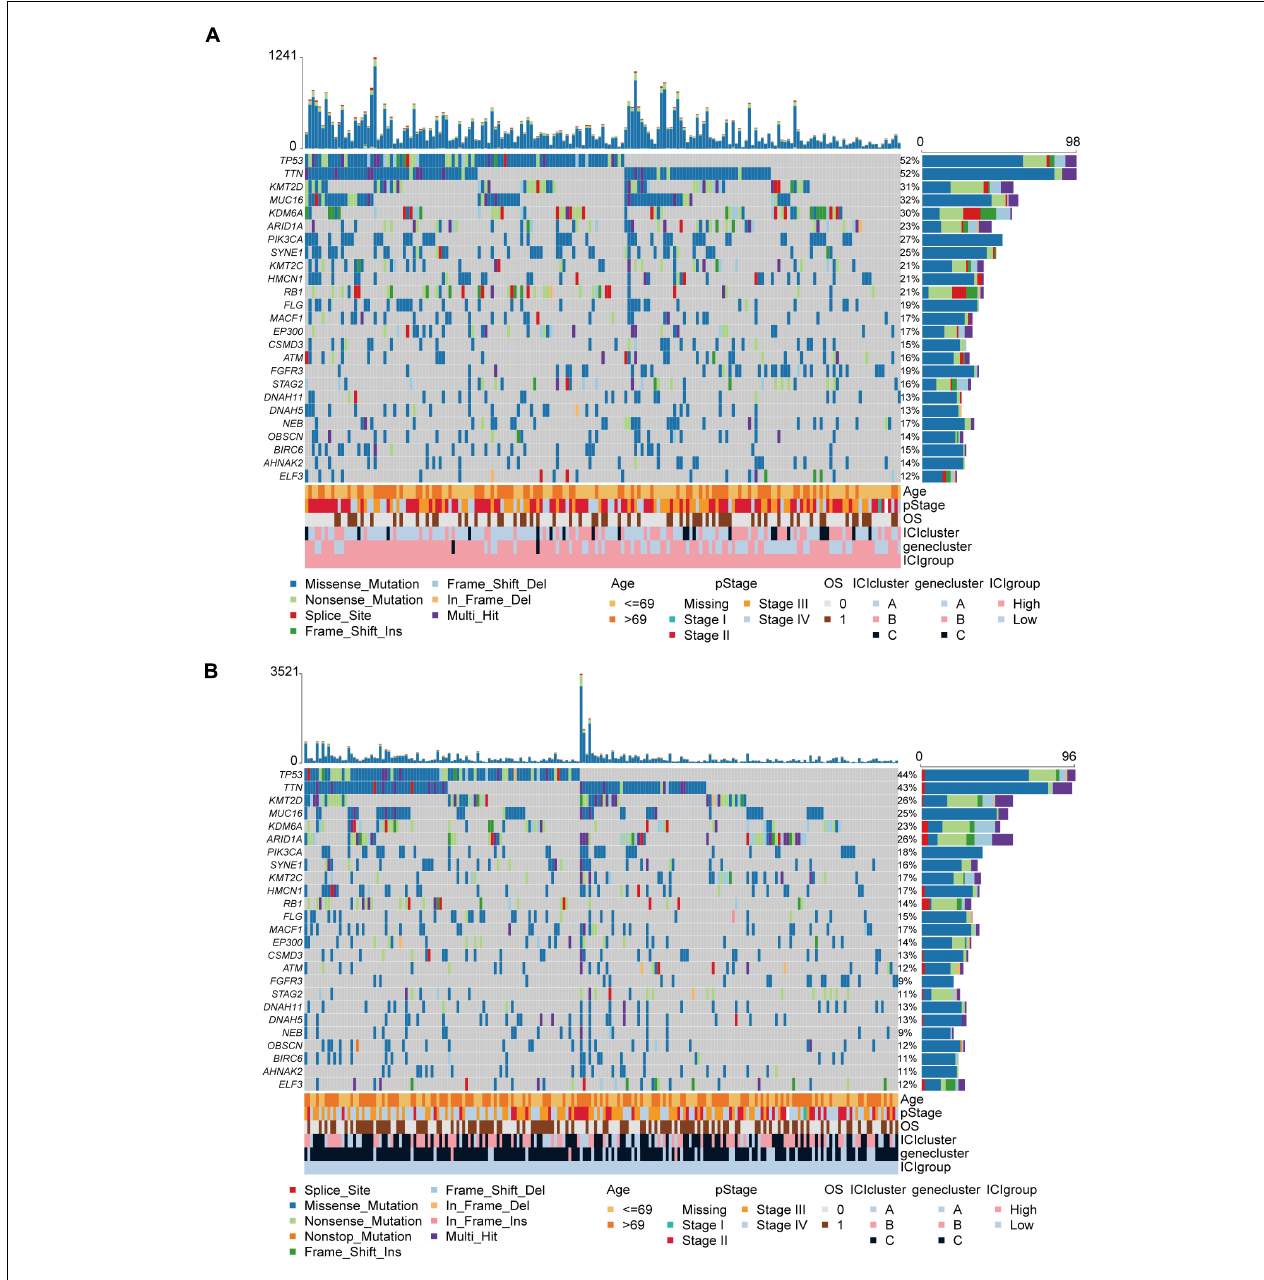
FIGURE 5 | The oncoPrint in the high (A) and low ICI score group (B) .